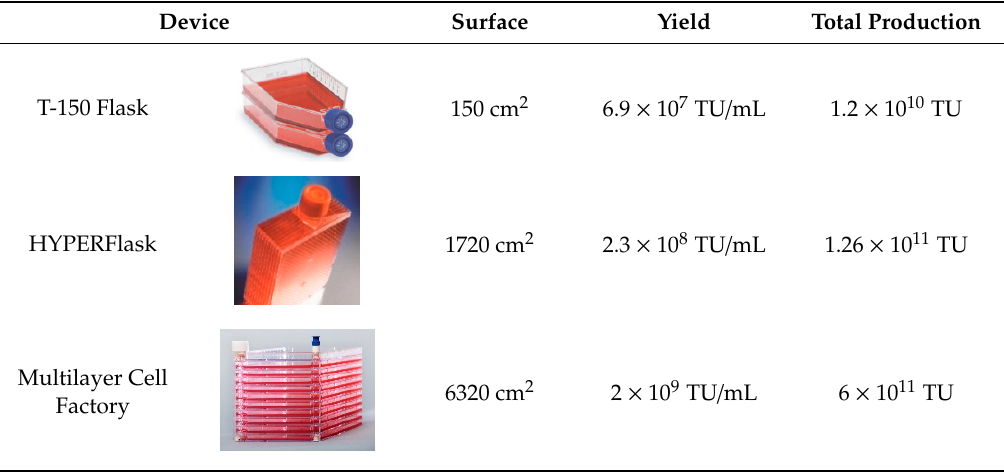
Table 2. Most-used 2D devices used for LV production.